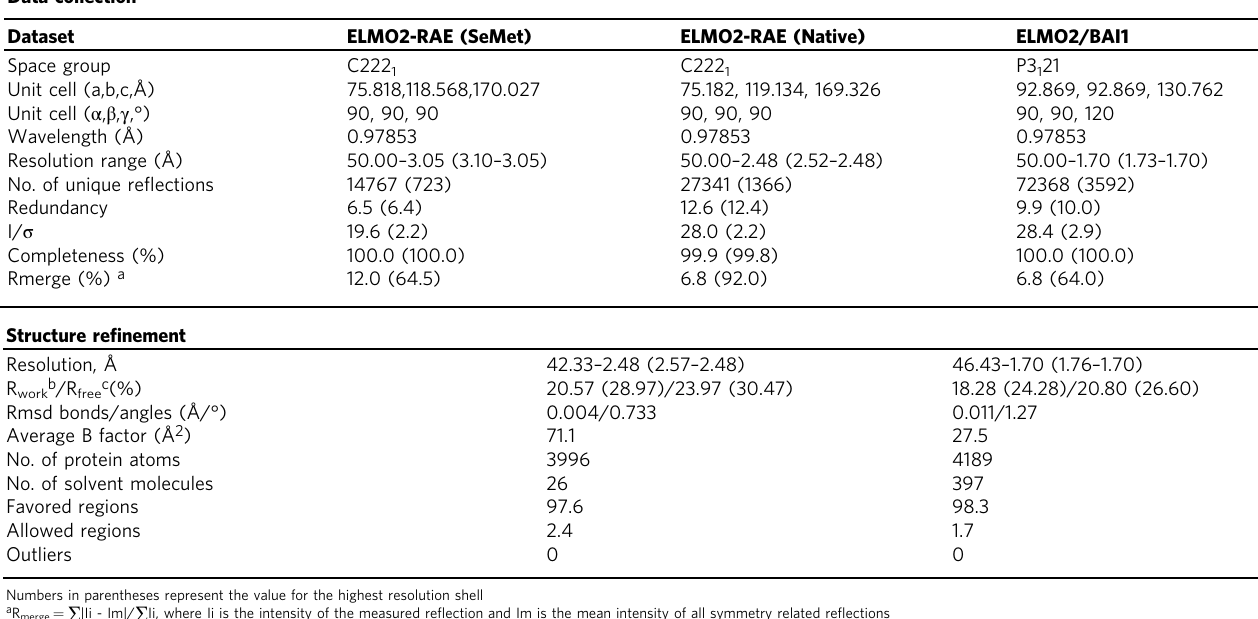
Table 1 Data collection and re fi nement